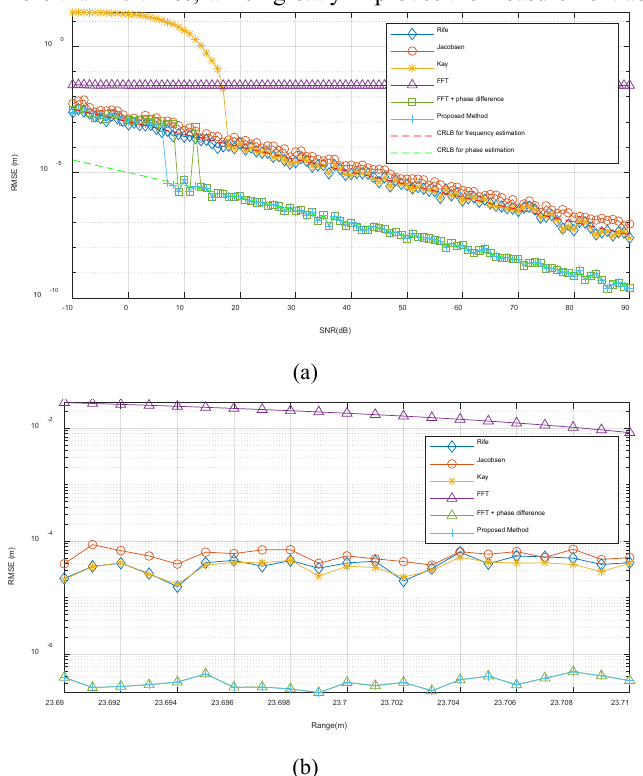
Fig. 2. Root-mean-square error (RMSE) vs. (a) SNR and (b) range by different methods.